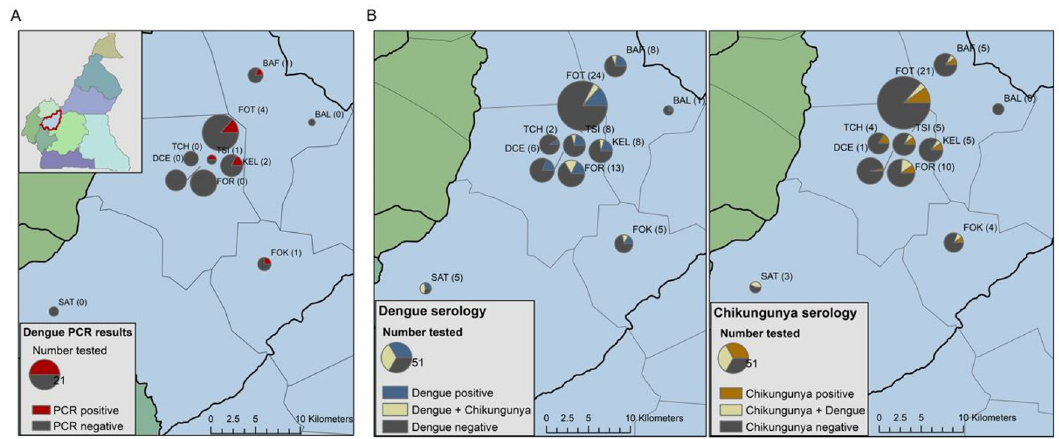
Fig 3. Distribution of rRT-PCR-positive DENV cases (A), and DENV (B), and CHIKV (C) seroprevalence were mapped by study site in Dschang Health District. Pie chart sizes were proportional of the number of samples tested for each assay. The abbreviated name of each study site appears next to each point with the number of samples positive for DENV via rRT-PCR (A), DENV IgG (B) or CHIKV IgG (C) in parentheses. For the DENV rRT-PCR results, sections of the chart corresponded to positive versus negative rRT-PCR results; for the DENV and CHIKV serology charts, sections corresponded to single infections (DENV or CHIKV only), DENV and CHIKV co-infections, and no DENV or CHIKV